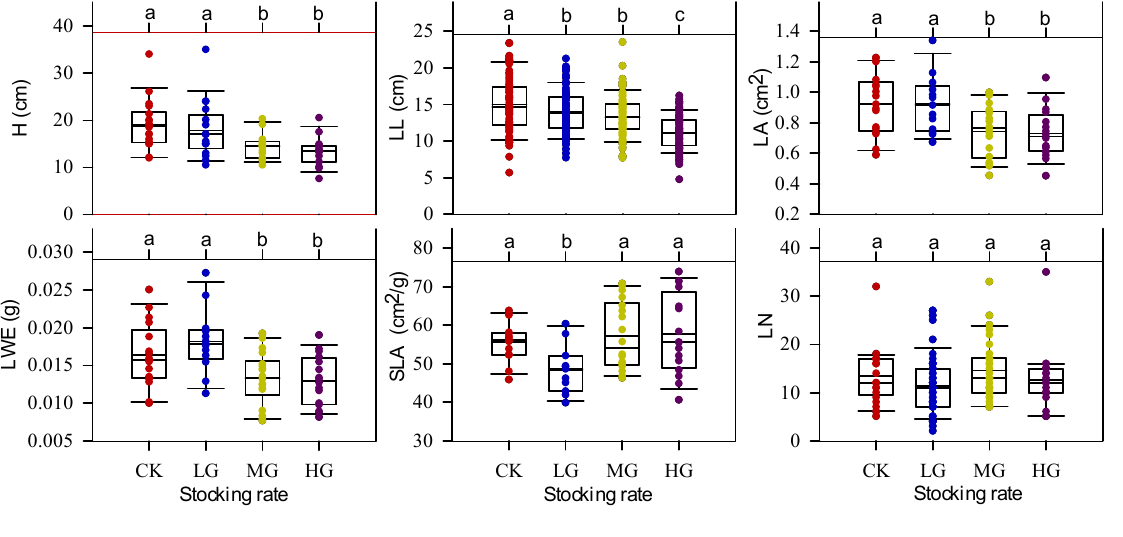
Figure 4 Aboveground traits of tillering Stipa breviflora individuals under four stocking rates. LWE – individual leaf mass; LL – average leaf length; H – average plant height; LA – leaf area; SLA – specific leaf area; LN – leaf number; CK – nongrazed; LG – lightly grazed (0.91 sheep unit hm − 2 half year − 1 ); MG – moderately grazed (1.82 sheep unit hm − 2 half year − 1 ); HG – heavily grazed (2.71 sheep unit hm − 2 half year − 1 ). Different letters represent significant differences between treatments ( p < 0.05).